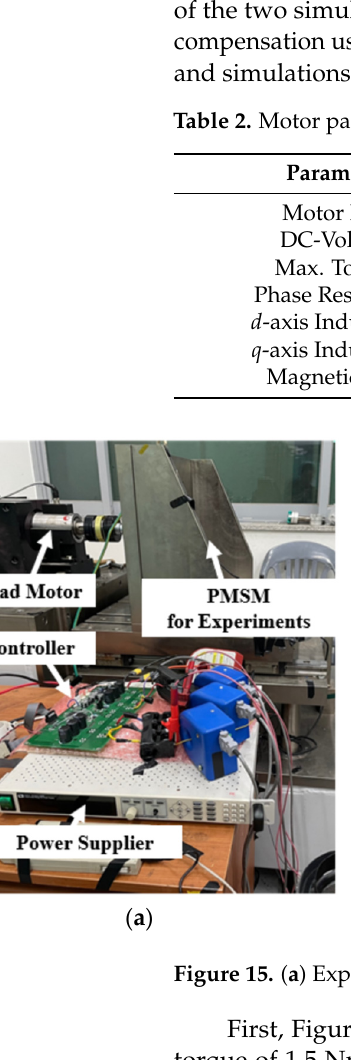
Table 2. Motor parameter values .